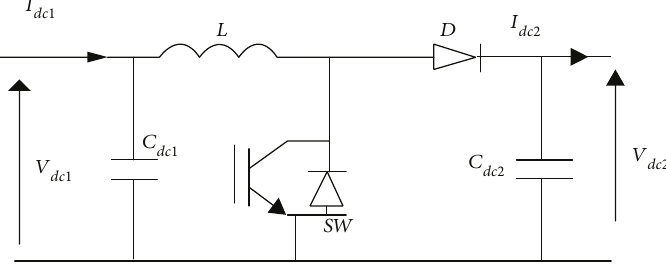
Figure 11: DC-DC boost converter circuit